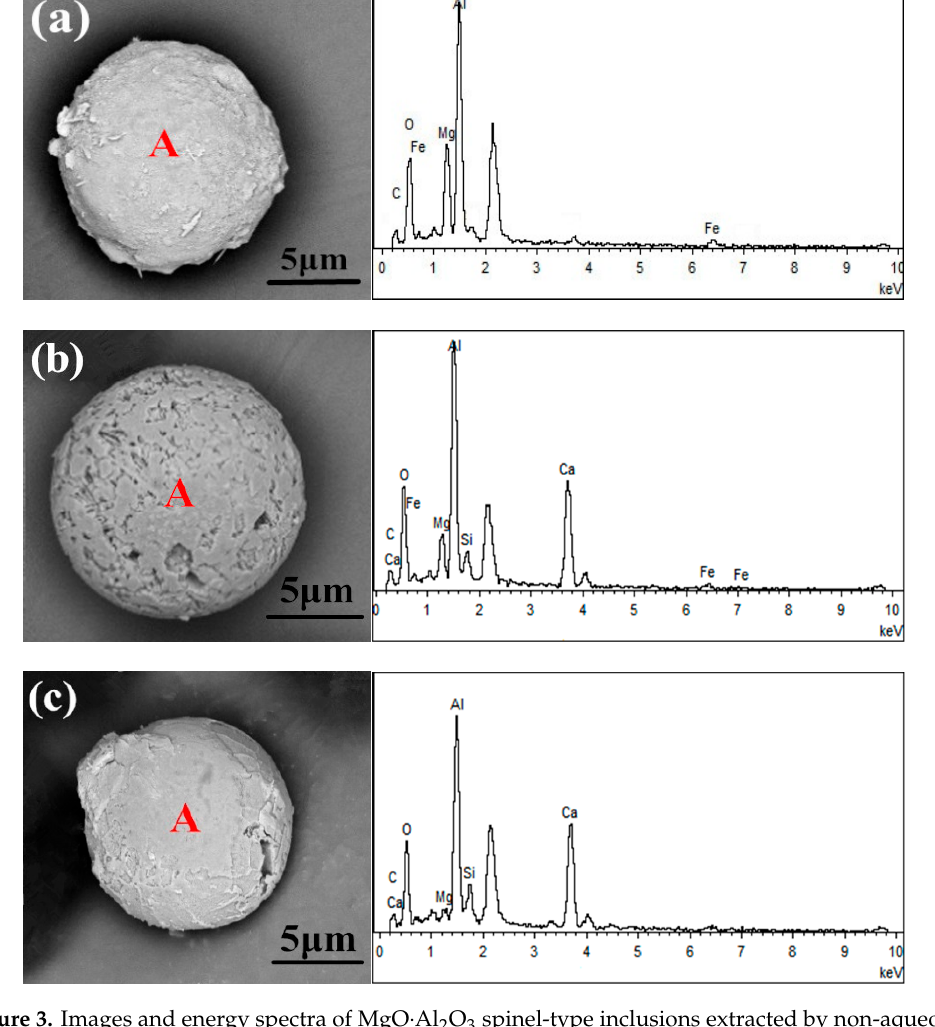
Figure 3. Images and energy spectra of MgO · Al 2 O 3 spinel-type inclusions extracted by non-aqueous electrolysis: ( a ) Independent MgO · Al 2 O 3 inclusions; ( b ) modified spinel inclusions containing Mg,